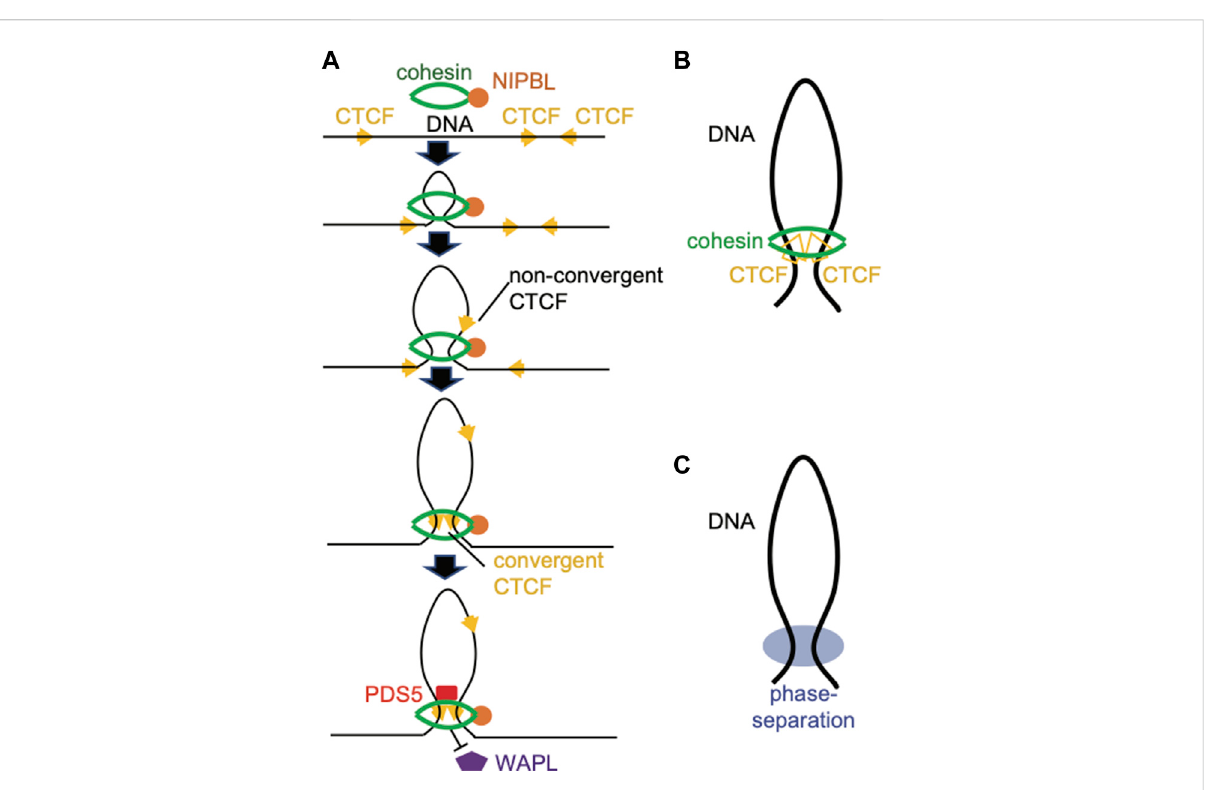
FIGURE 2 Schematic of 3D genome structure. (A) Illustration of a loop extrusion model, in which NIPBL, stabilized by BRD4, loads the ring-like cohesin complex onto target chromatin and activates its ATPase to extrude the DNA fi ber. A pair of convergent CTCF proteins, and not those in the non- convergent con fi guration, stall cohesin ’ s sliding and prevent WAPL from releasing the cohesion complex off chromatin. PDS5 binds cohesin to stabilize its residence on the loop anchor. (B) Long-range chromatin interactions driven by the cohesion complex, with CTCFs serving as anchors. (C) Long-range chromatin contacts driven by a phase separation-based